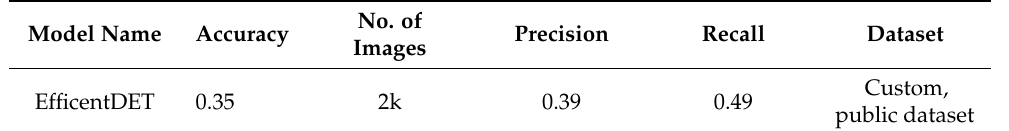
Table 8. EfficentDET results.